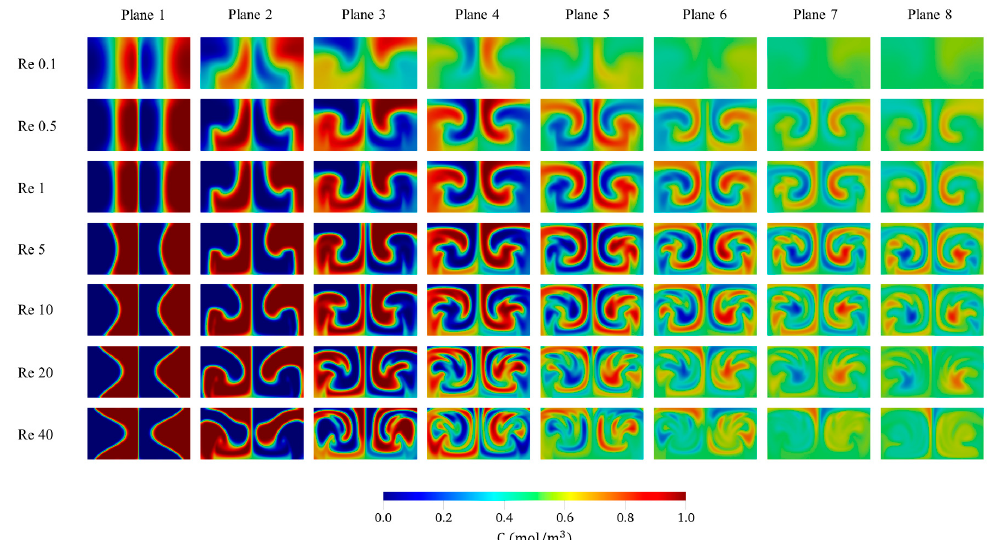
Figure 9. Concentration distributions in the mixing channel for the CSCR-VS-AI configuration ( D = D 1 ). Plane 1 and 8 represent cross-sections at x = 100 µ m and at the outlet respectively. Planes from 2 to 7 show the cross-sections, 100 µ m after the center of odd-number semi-circular ridges starting from the confluence region. All planes are normal to the x -direction.